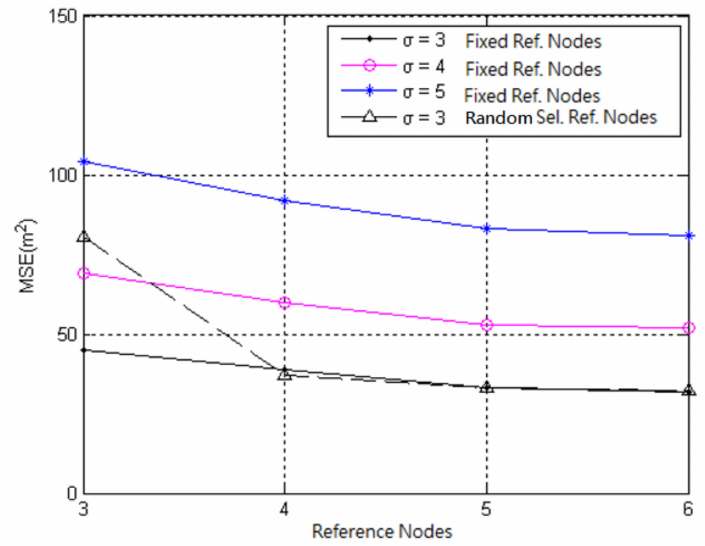
Figure 13. Comparison of the estimation of a large range of fixed reference nodes and random reference nodes.